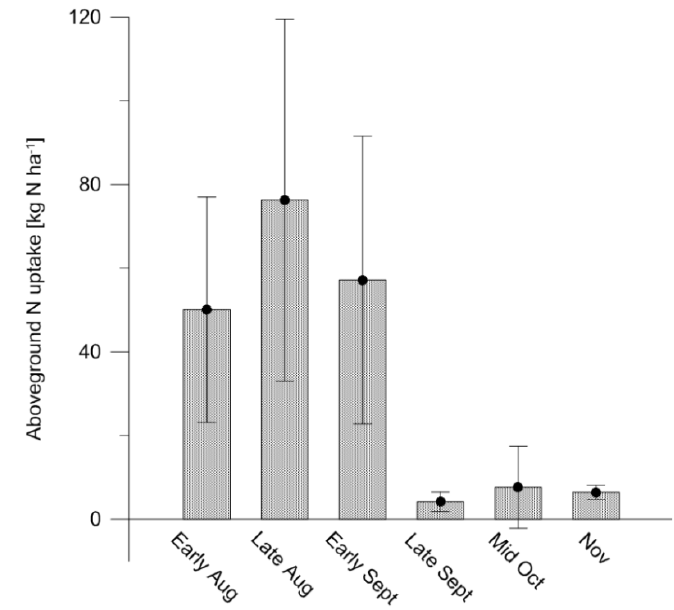
Figure 1. Effect of sowing date on the aboveground N uptake by catch crops measured in autumn [97,105–107,109–111].